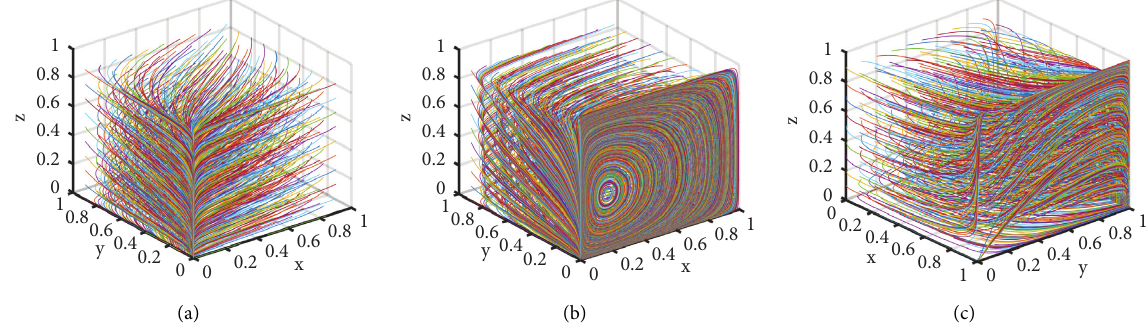
Figure 7: Impact of penalties on the evolution of each player’s